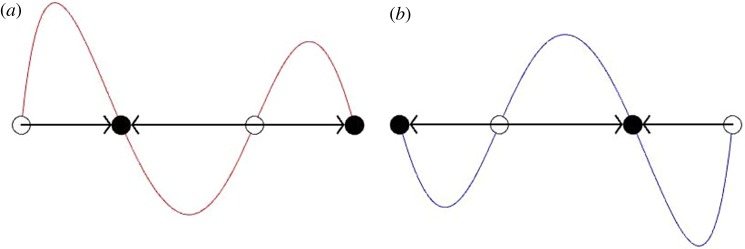
Deterministic flow in the two environments, we plot x˙ as a function of x; see text for details. The internal fixed points are located at x⋆=0.3 and x⋆=0.7. The environment σ=1 is shown in (a) and σ=−1 is shown in (b). The fixed points have opposite stability in the two environments. There are only two options for choosing the direction of flow in the two environments, given that the fixed points remain in the same locations: the direction of flow is the same in both environments or the direction of flow is opposite. The most interesting is the former but we also discuss the latter in the electronic supplementary material. We also discuss the method of choosing pay-off matrix elements such that fixed points are at designated locations in the electronic supplementary material.